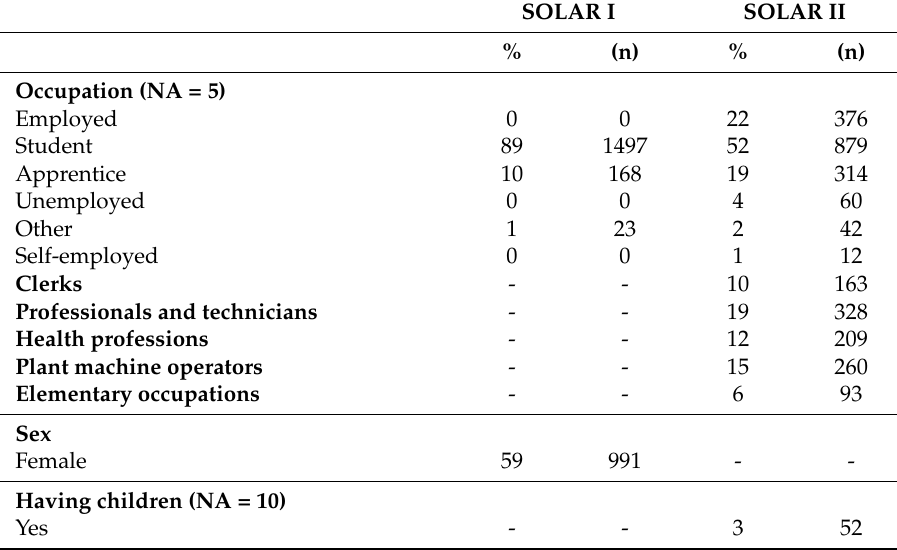
Table 1. Descriptive data of outcomes, exposures, and potential confounders at SOLAR I (2002–2003) and II (2007–2009) in 1688 young Germany adults prior to imputation. Where data for SOLAR I and II remained constant, only data for SOLAR I are